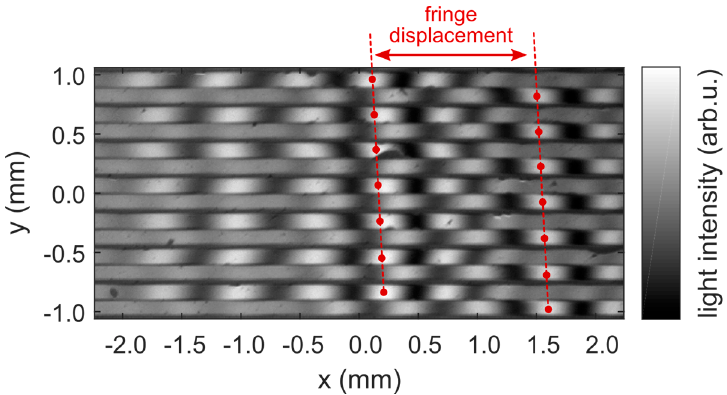
Figure 3. Surface fragment of the SDU seen through the WLI camera. The image clearly shows horizontal facets of the gratings with white light interference fringes on their surface. Neighboring facets belong to different gratings. One of the gratings is displaced along the surface normal ( z -direction) as is indicated by the shift of the interference pattern.